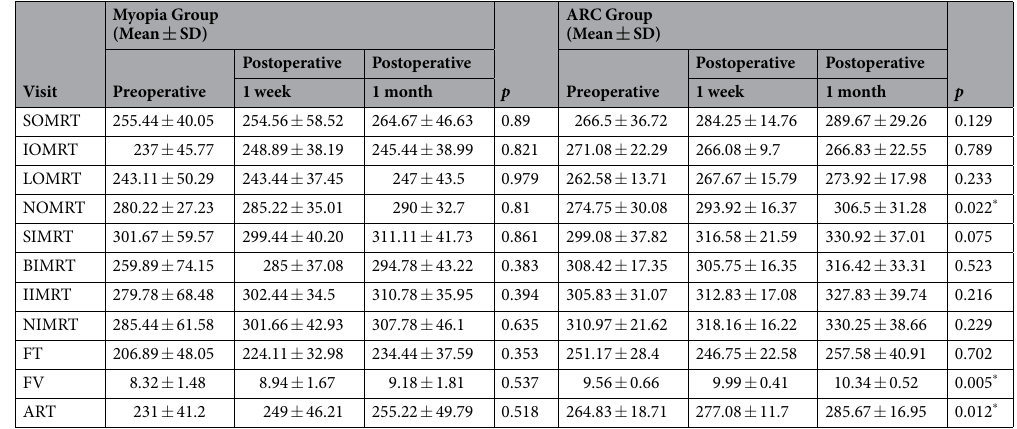
Table 3. The Time Points for Comparison of Retinal Thickness Values. SOMRT = superior outer macular ring thickness; BOMRT = bitamporal outer macular ring thickness; IOMRT = inferior outer macular ring thickness; NOMRT = nasal outer macular ring thickness; SIMRT = superior inter macular ring thickness; BIMRT = bitamporal inter macular ring thickness; IIMRT = inferior inter macular ring thickness; NIMRT = nasal inter macular ring thickness; FT = foveal thickness; FV = foveal volume; ART = average retinal thickness; CDE = cumulative dissipated energy.